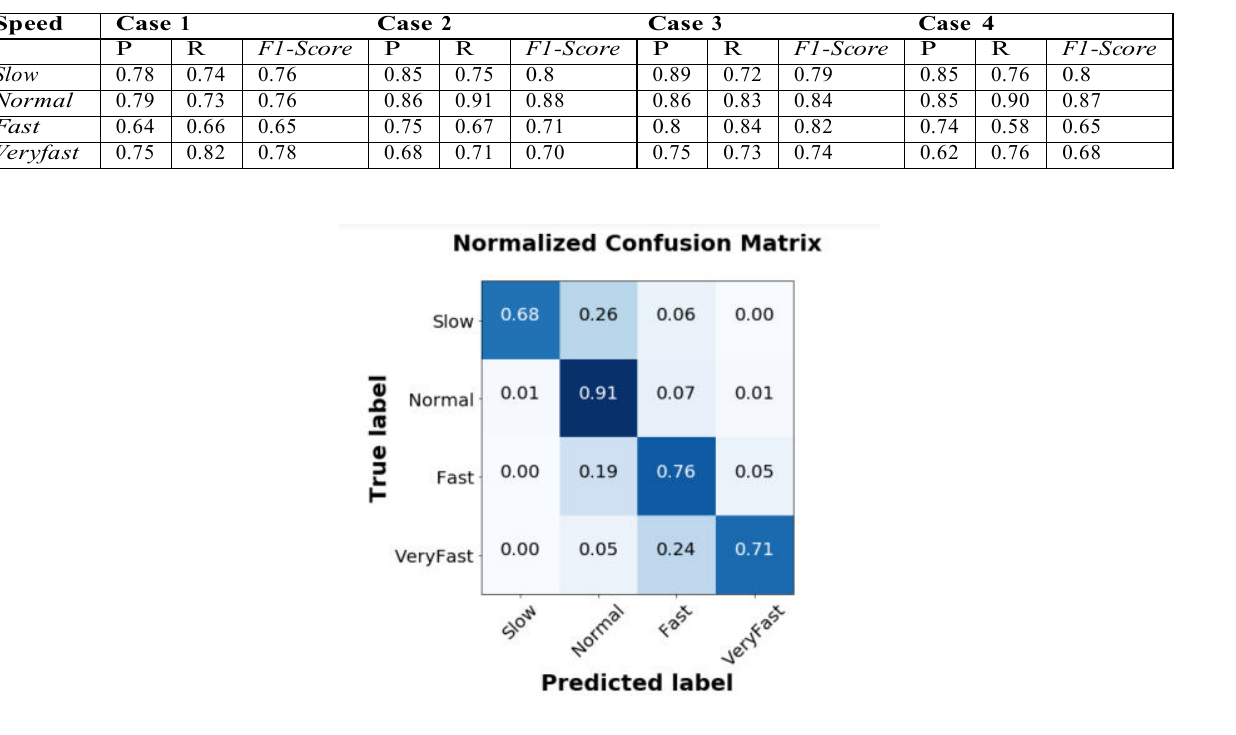
Figure 9. Confusion matrix for GB classification